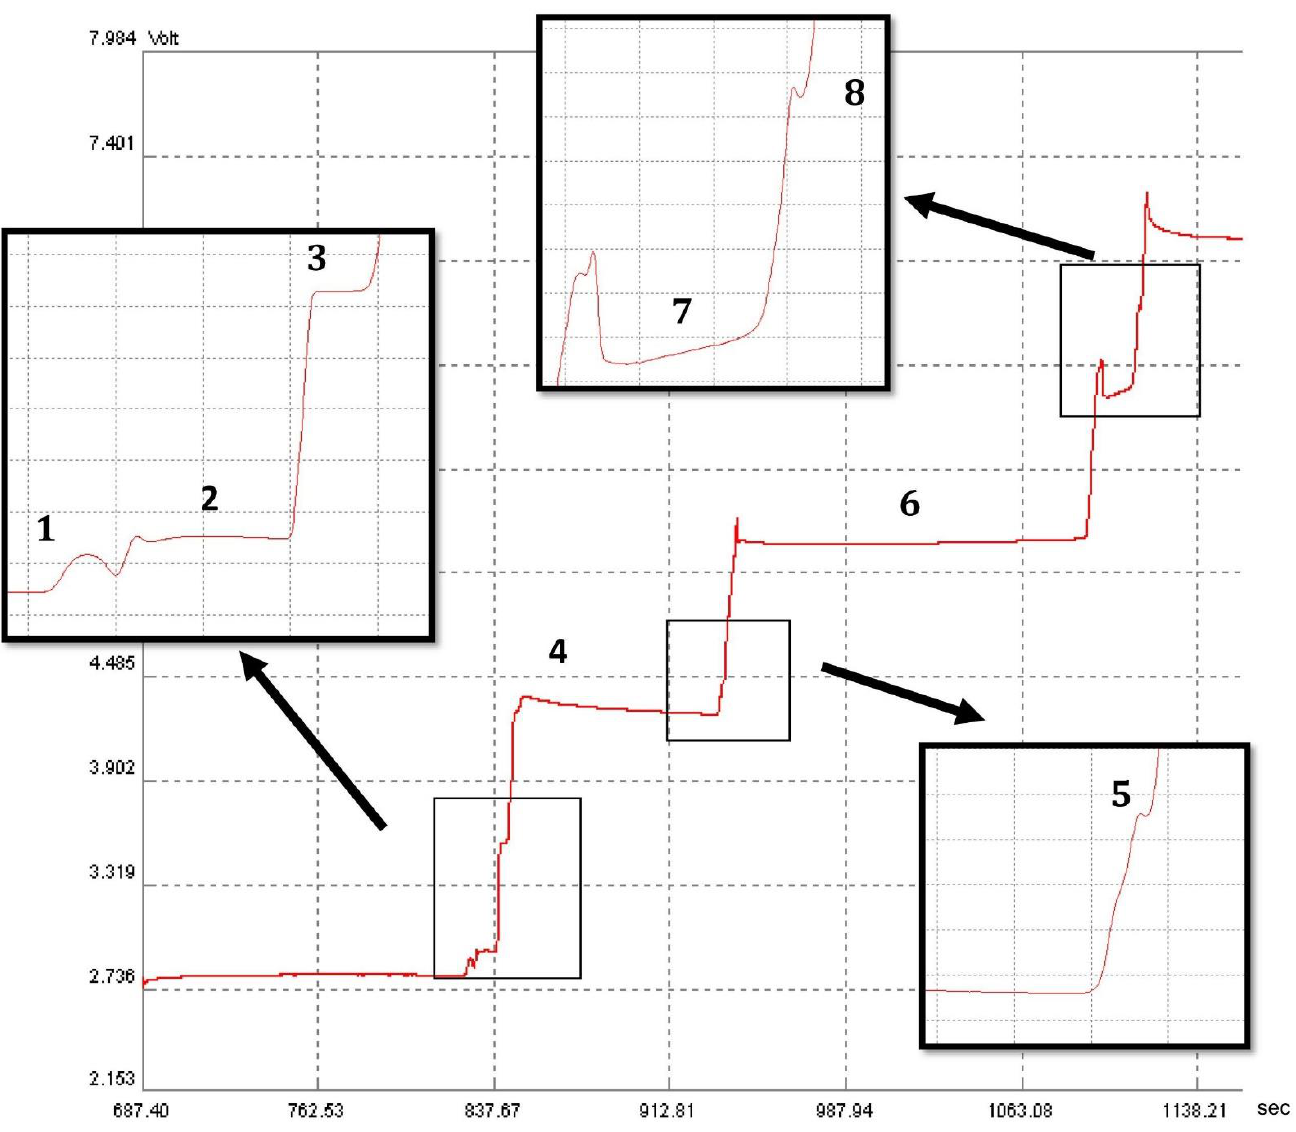
Figure 2. Isotachophoretic separation of acids in saliva (isotachophoregram). Zone assignments: LE—leading electrolyte; 1—nitric acid; 2—thiocyanic acid; 3—formic acid; 4—phosphoric acid; 5—lactic acid; 6—acetic acid; 7—propionic acid; 8—butyric acid; TE—terminating electrolyte.